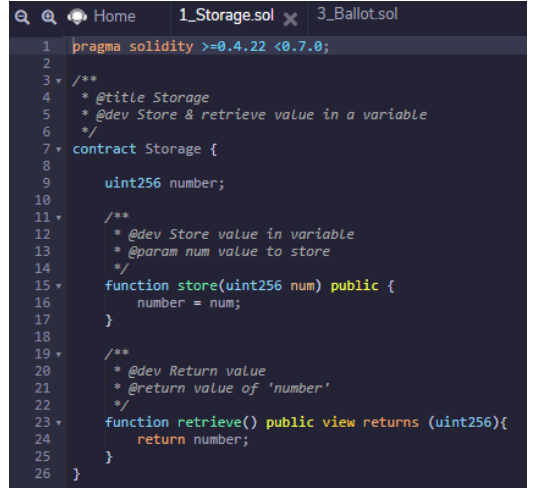
Figure 7. Programming